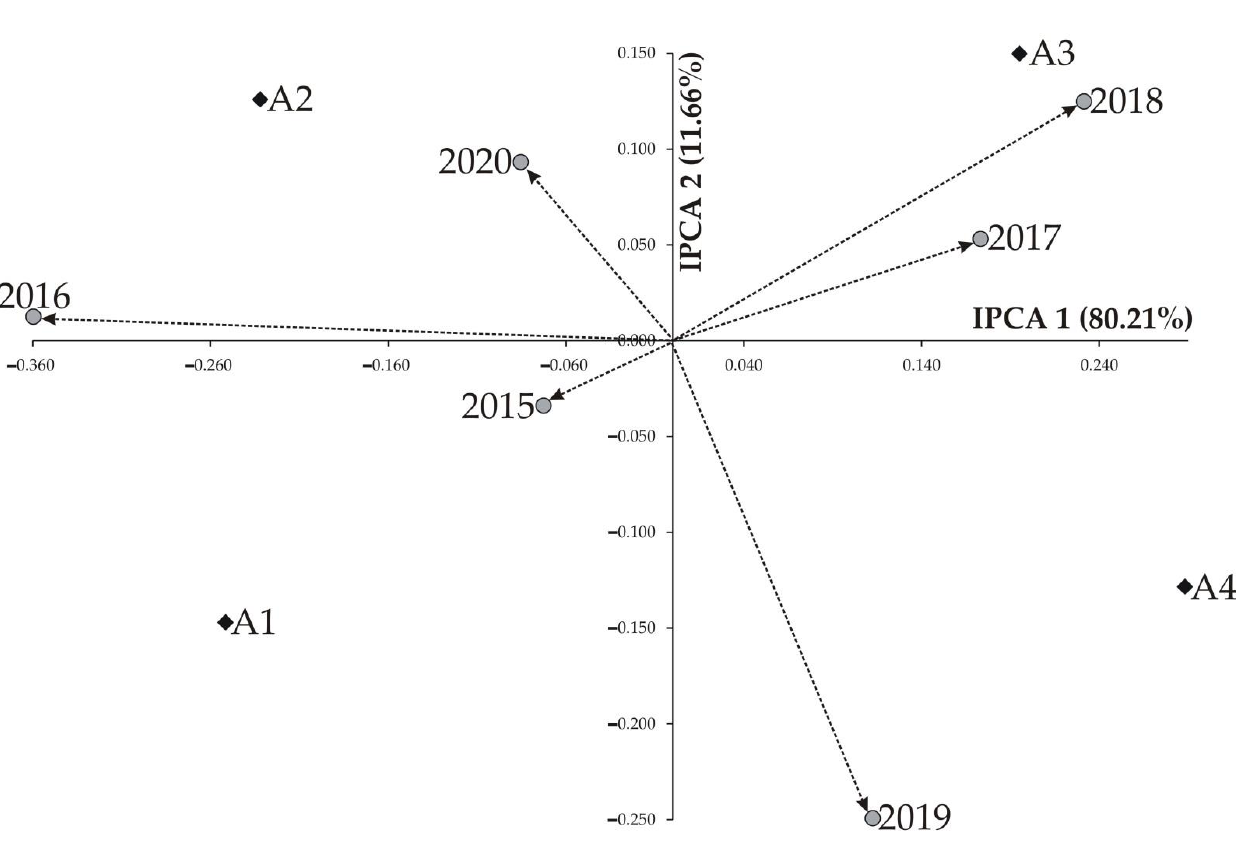
Figure 2. Biplot for NP fertilizer placement depth by year interaction of the number of plants after emergence for four NP fertilizer placement depths of maize ( Zea mays L.) during six years, showing the effects of primary and secondary components (IPCA 1 and IPCA 2, respectively) (A1—0 cm (broadcast), A2—5 cm (in rows), A3—10 cm (in rows), A4—15 cm (in rows)).